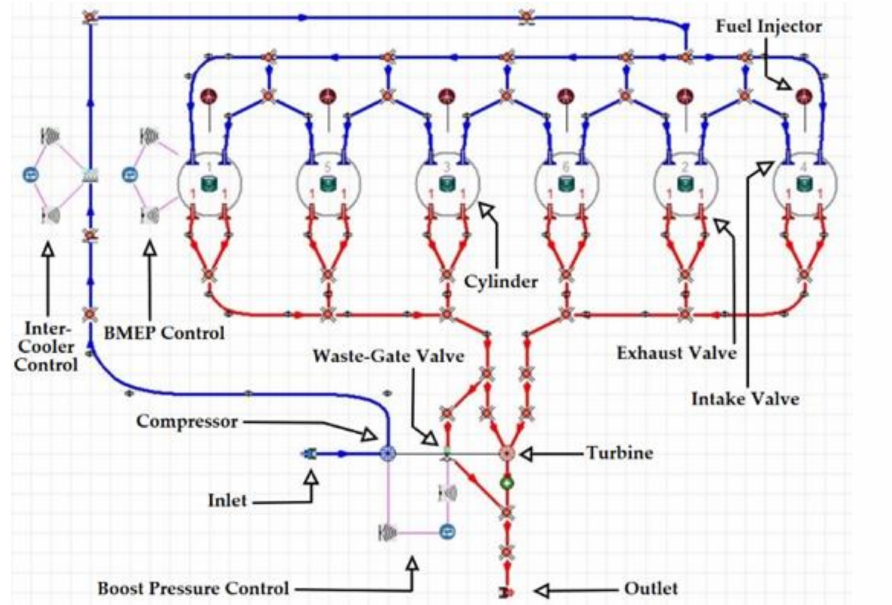
Figure 6. Six-cylinder turbocharged Diesel engine, 0D/1D